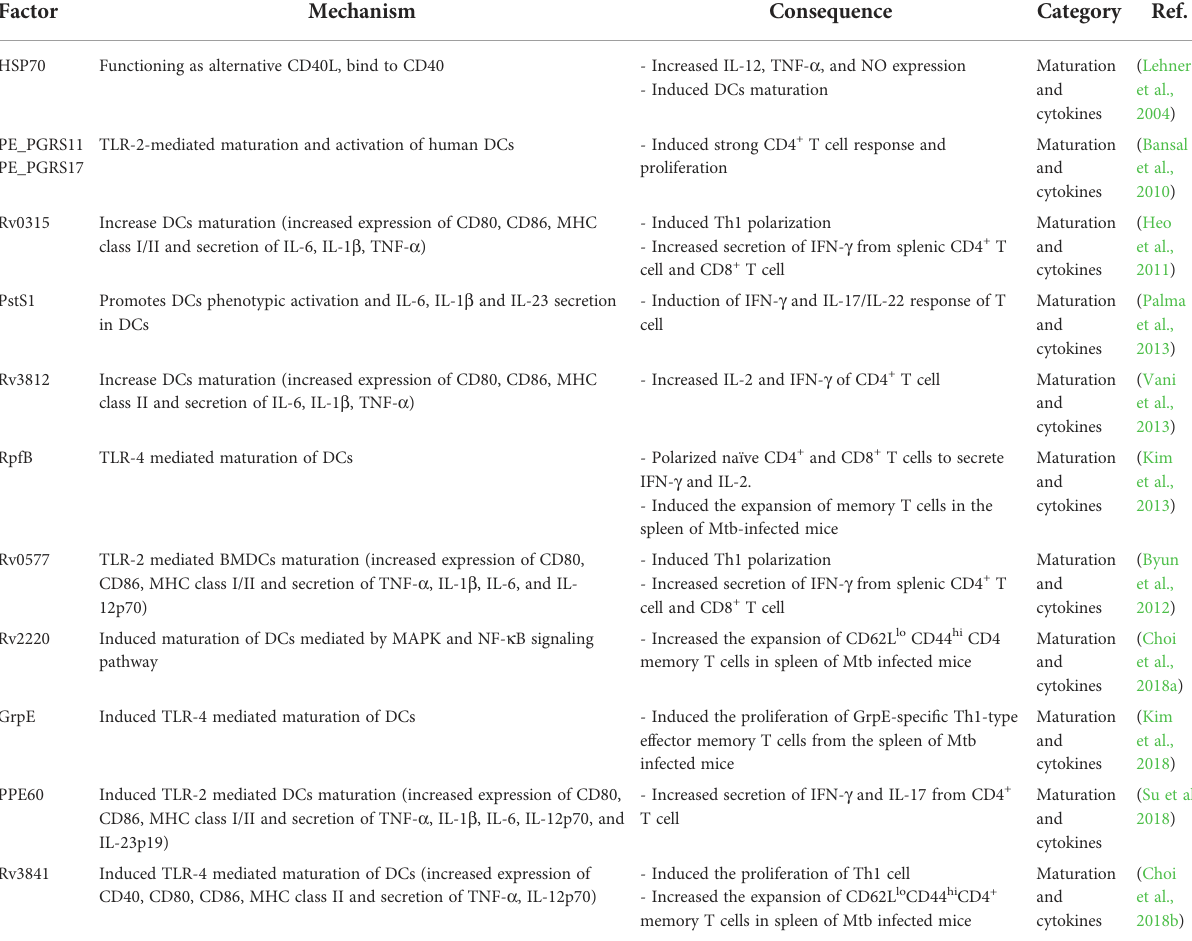
TABLE 2 Ags of Mtb that induce DC